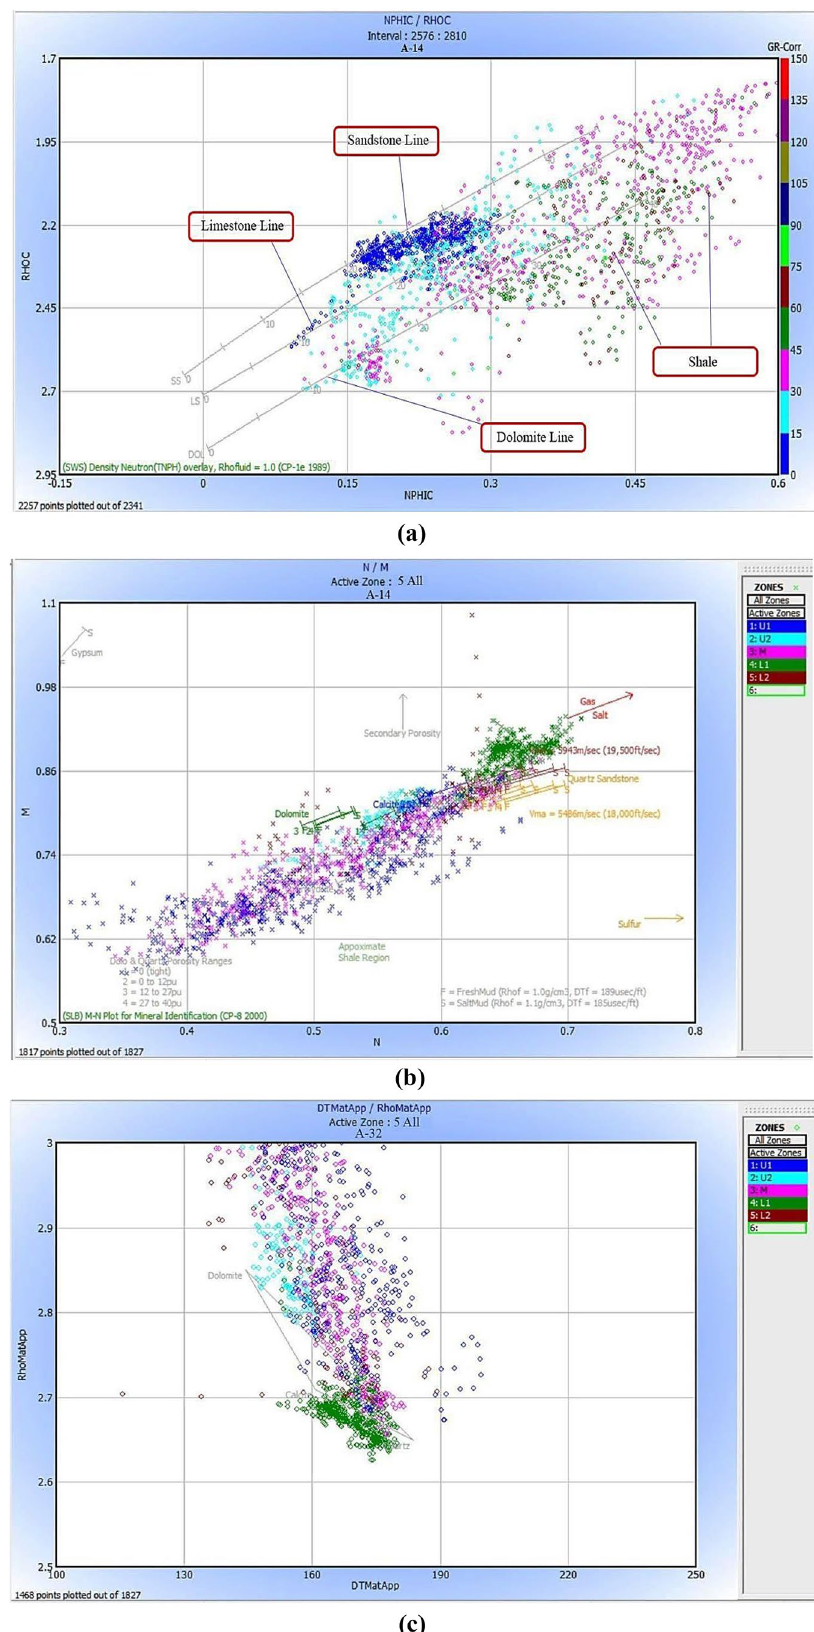
Fig. 10 Lithology determina- tion of the Albian sequence in A-17 well using a the density (RHOC)-neutron porosity (NPHIC) cross-plot, accompa- nied with the gamma-ray bar (GR), b M–N cross-plot, and c matrix density (RHOMat)- transit time (DT)